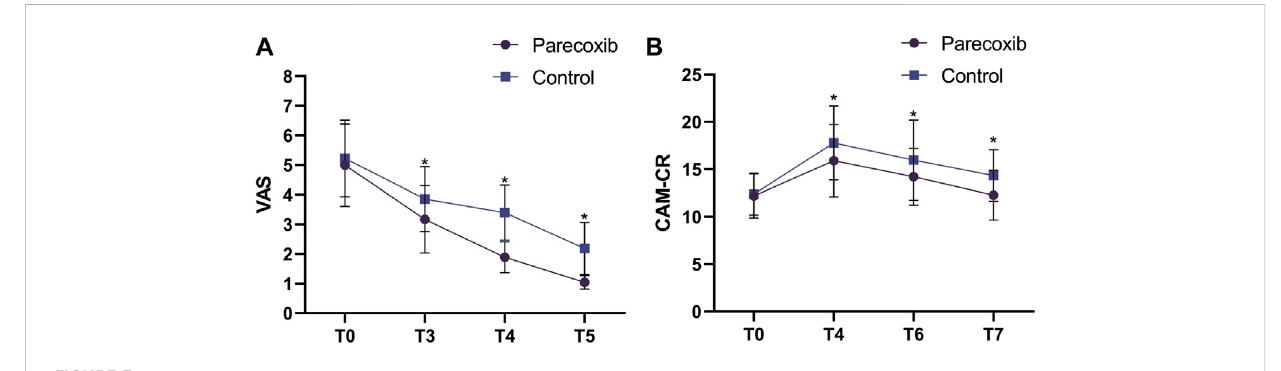
FIGURE 3 VAS (A) and CAM-CR (B) score changes at different time